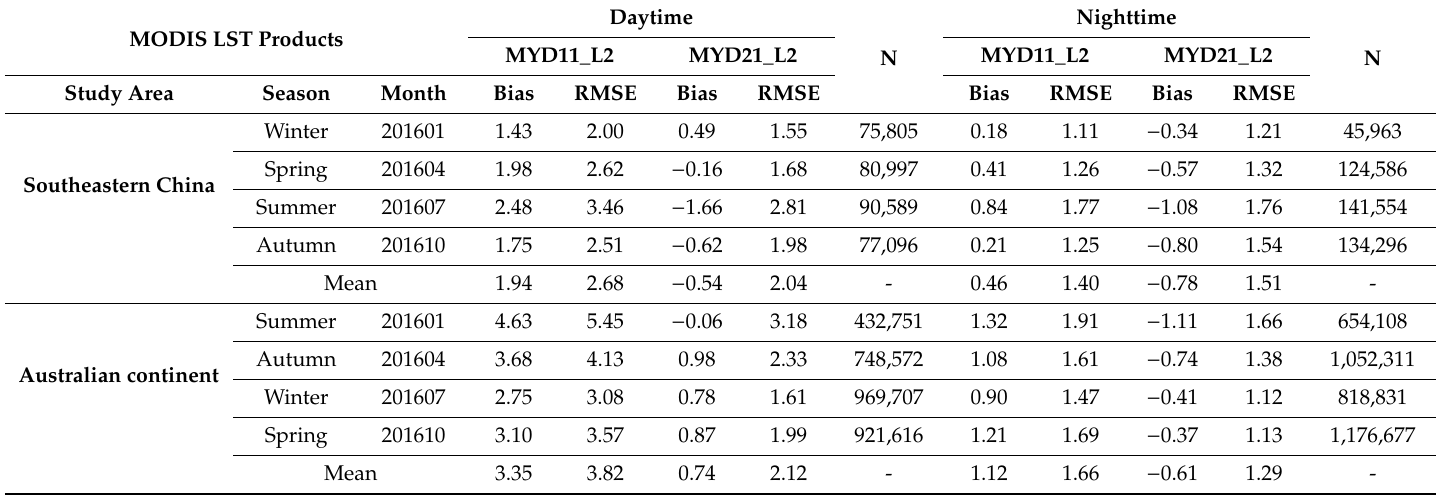
Table 10. Comparison of the AHI LSTs versus two MODIS LST products during the daytime and nighttime in four months of 2016 across the two study areas.